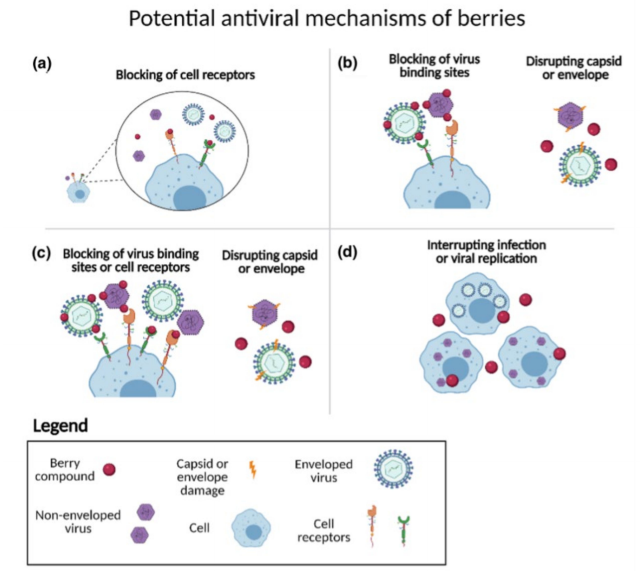
Figure 1. Graphical description: ( a ) pre-incubation of the cells, ( b ) pre-incubation of the virus, ( c ) co-incubation, ( d )